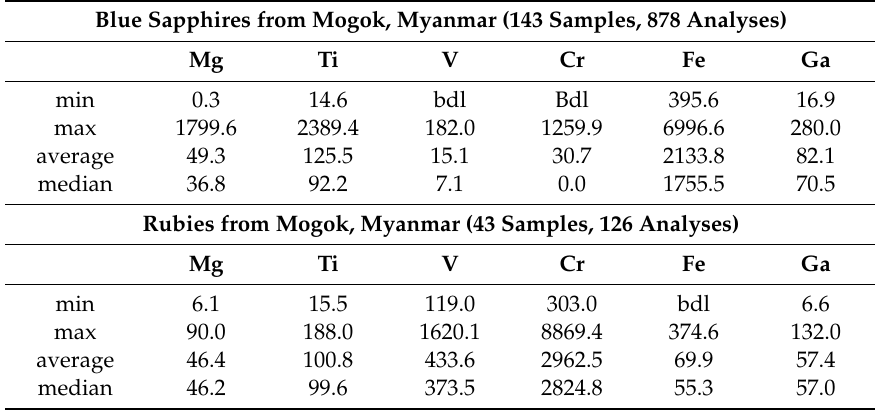
Figure 3. Trace element plots of rubies and blue sapphires from Mogok, Myanmar, showing their representative range of trace element profiles. Table 4. Summary of trace elements for sapphires and rubies from Mogok, Myanmar, in ppm. Blue Sapphires from Mogok, Myanmar (143 Samples, 878 Analyses)